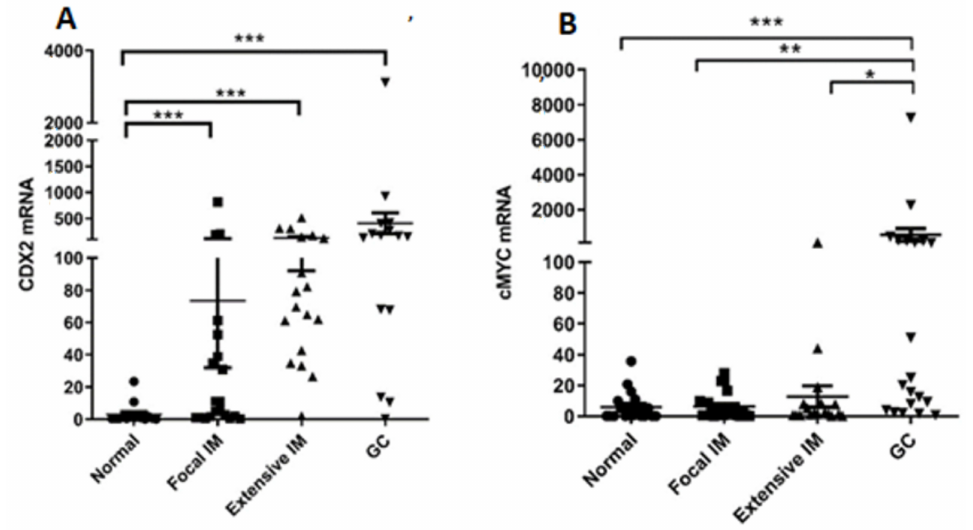
Figure 5. Expression levels of transcription factors: ( A ) CDX2 and ( B ) c-MYC in normal ( • ), focal IM ( (cid:4) ), extensive IM ( (cid:78) ), and GC ( (cid:72) ) gastric biopsies measured by qPCR. * p < 0.05; ** p < 0.005; *** p < 0.001. Mean ±